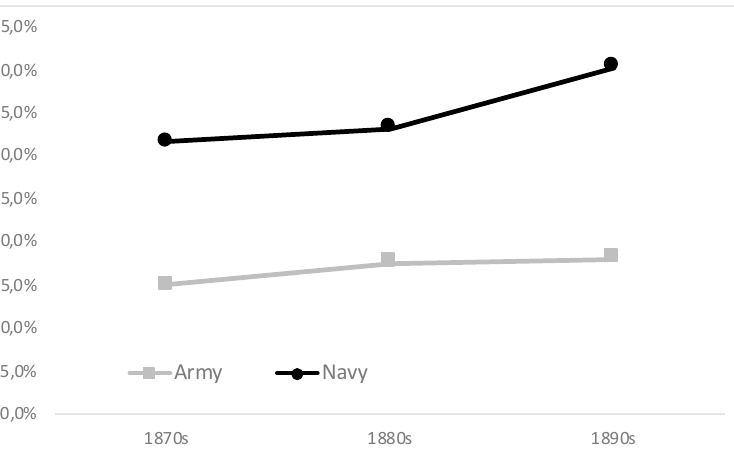
Figure A1. Source: Figure 2 for army records, Llorca ‐ Jaña et al. [29] for navy records. Note 1: The navy sample for those born from the 1870s to the 1890s include 28.431 observations, for marines aged 18 to 55. The average raw height is 164.1 cm and the SD is 6.2 cm, while the comparable values for the army sample are 166.7 and 6.1 cm, respectively. Note 2: The estimates based on naval records are far higher than those of the army due to some restrictions imposed by the Chilean navy, including some health requirements. Marines tend to be shorter than soldiers in the army, since navies around the world had lower minimum height requirements than the army: Tall navy recruits were usually excluded from navies given the limited size of ships’ cabins. There are fewer men of exceptional height than might be expected for a normal distribution [29].